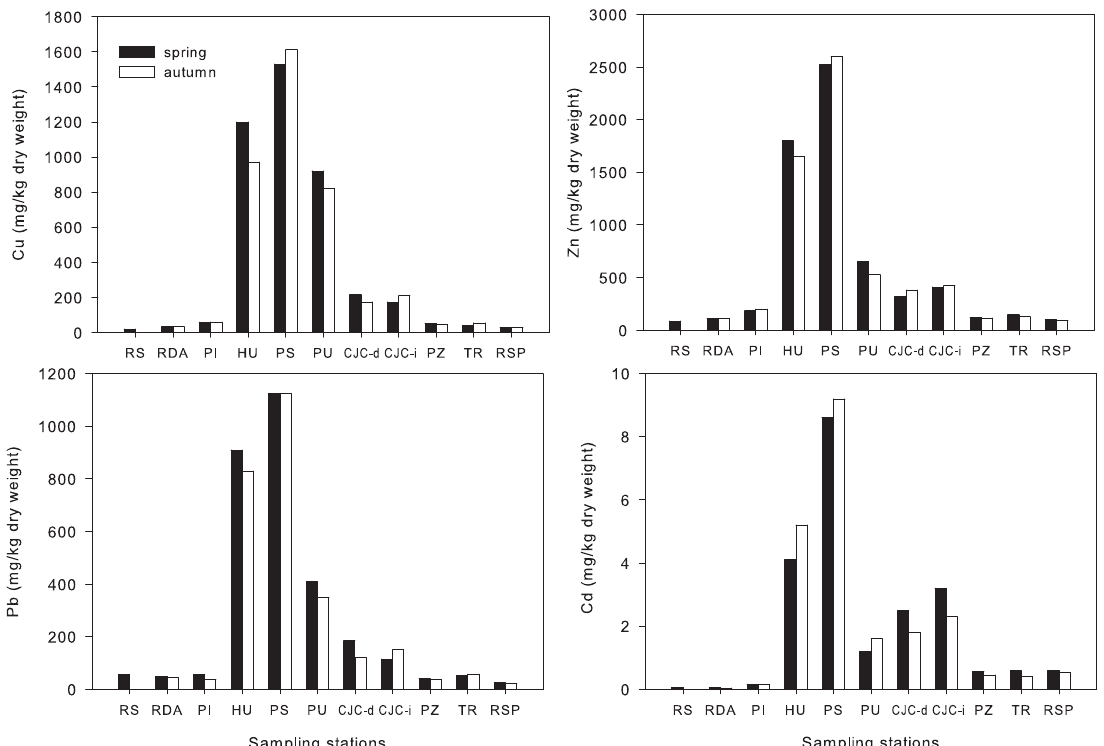
Fig . 2. – Concentrations of copper, zinc, lead and cadmium (mg kg -1 dry sediment) at the sampling stations for spring and autumn.